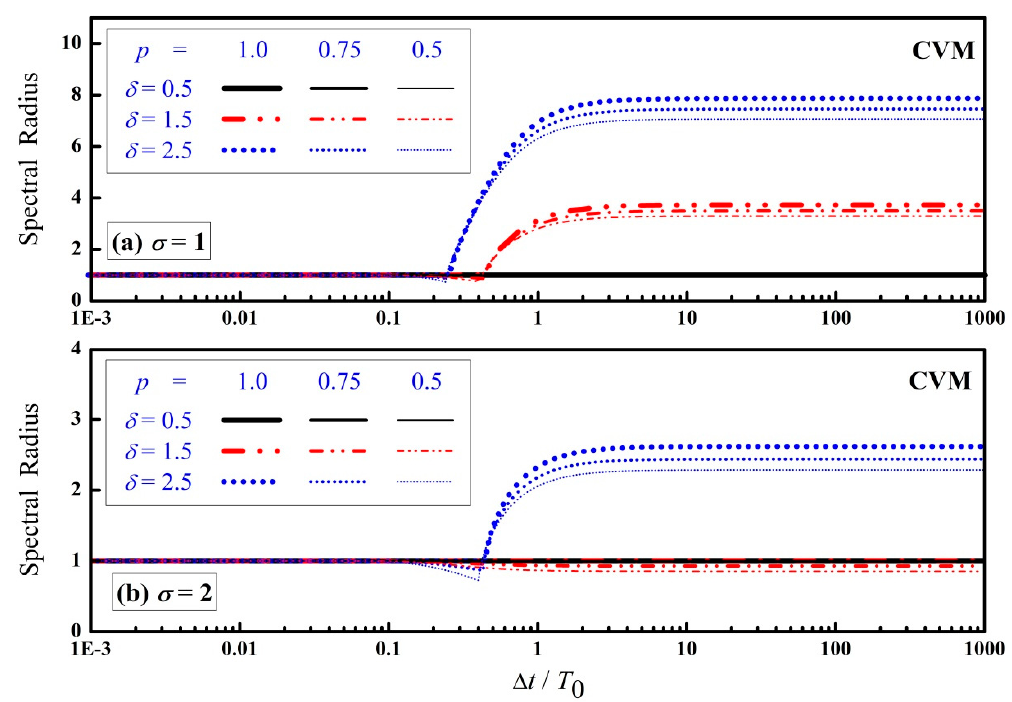
Figure 3. Variation of the spectral radius with ∆ t / T 0 .